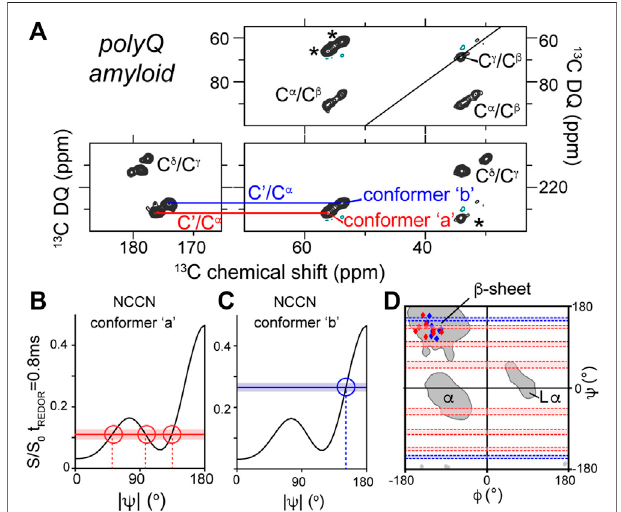
FIGURE 3 | NCCN analysis of polyQ amyloid structure. (A) 2D SQ-DQ spectrum from a NCCN measurement on polyQ amyloid fi brils, showing the main peaks of the two conformers called ‘ a ’ (red) and ‘ b ’ (blue) that make up the polyQ amyloid core. (B,C) Comparison of experimental S/S 0 values (horizontal lines) to simulated ψ -dependence S/S 0 ratios (black lines) for each conformer. (D) Ramachandran plot showing the integration of TALOS and NCCN analysis of the structures of polyQ amyloid conformers a and b. See also Figure 4 below. Figure adapted with permission from ref. (Hoop et al.,